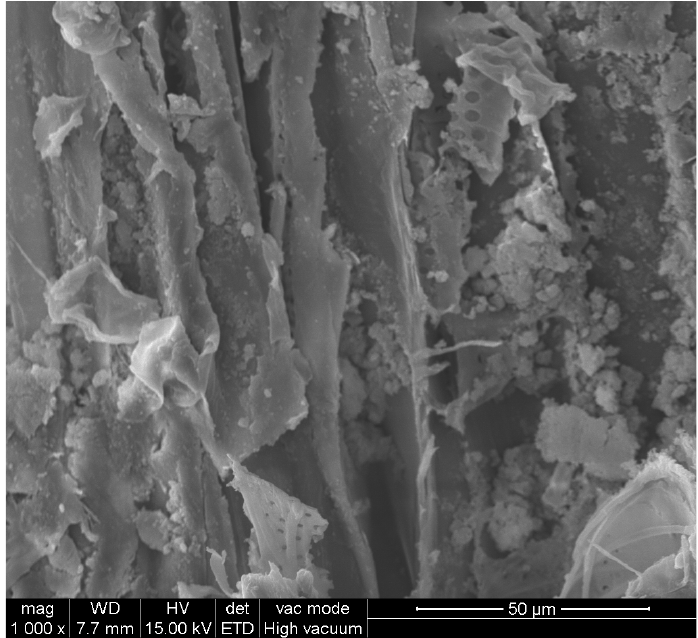
Figure 10. Dye buildup of bleached